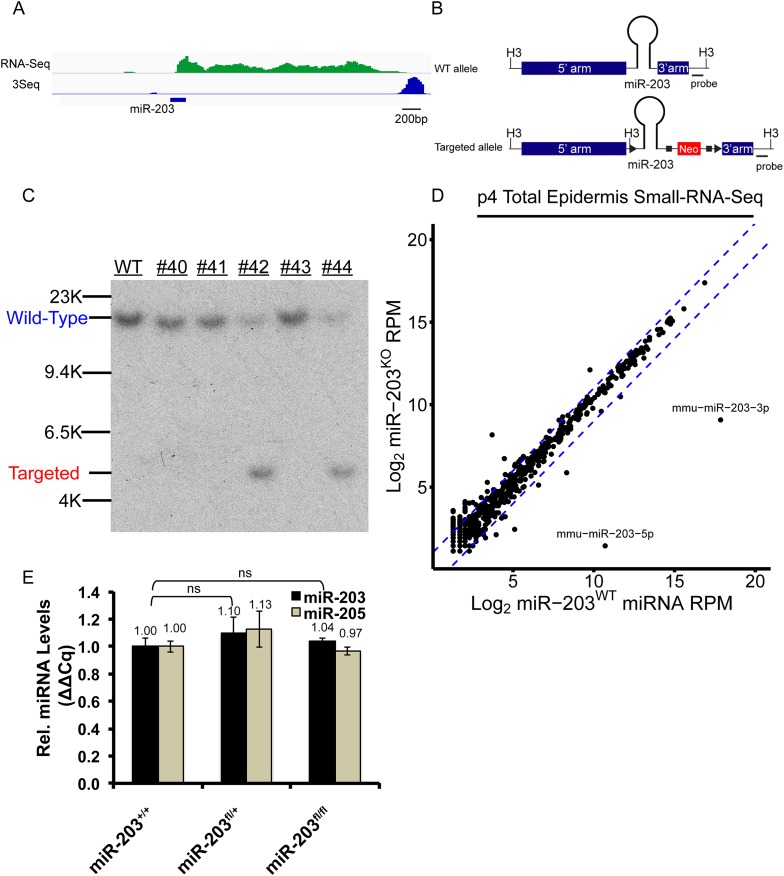
Generation of a miR-203 conditional knockout mouse.(A) RNA-Seq and 3Seq detection of the miR-203 primary transcript (B) Schematic of the miR-203 conditional allele. H3 = HindIII (C) Southern blot confirmation of founder miR-203 conditional knockout mice (D) Small-RNA-seq confirmation of miR-203 loss. Blue lines indicate twofold change (E) qPCR quantification of miR-203 and miR-205, demonstrating that the miR-203floxed allele does not alter microRNA levels. Error bars represent S.E.M from reactions performed from n = 2 mice in technical triplicate, ns = non-significant.